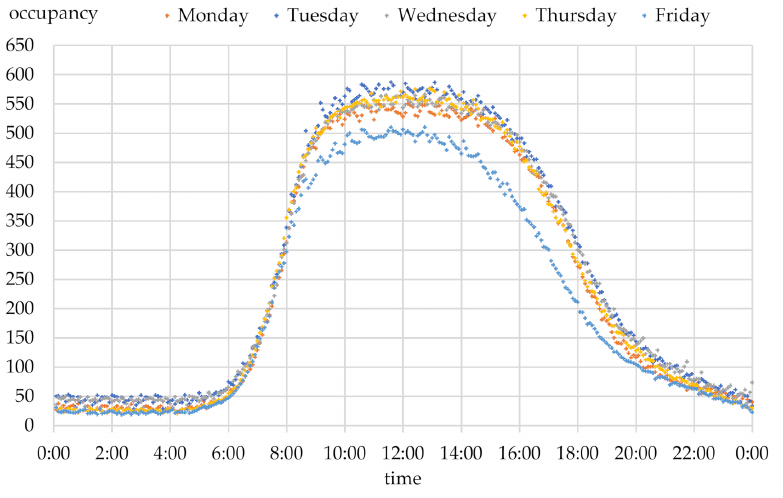
Figure 4. Occupancy on weekdays ([33], calculated by authors).